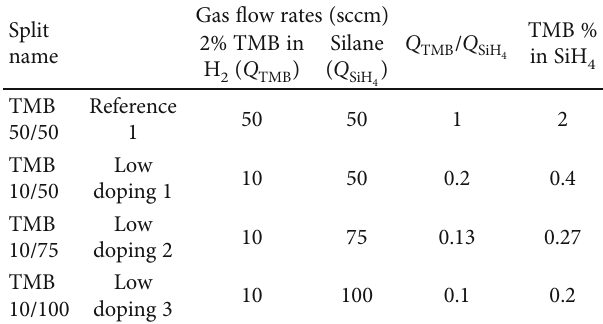
) and 2% TMB in H SiH 4